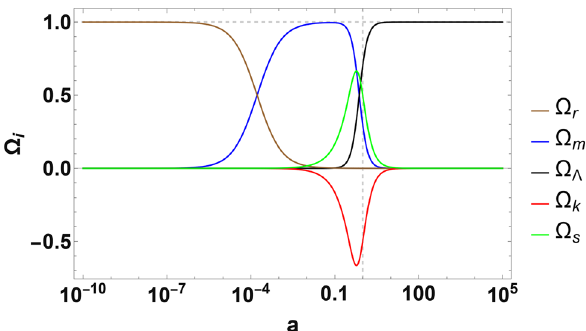
Fig. 1 Qualitative plot of the density parameters as a function of the scalefactorwithlogarithmicscalein a .Thechosenvaluesforthedensity parameters today are (cid:18) r , 0 = 5 × 10 − 5 , (cid:18) m , 0 = 0 . 3, (cid:18) (cid:2), 0 = 0 . 7 and (cid:18) = − 0 . 5.Theinferredvalueforthetorsiondensityparametertoday k , 0 is therefore (cid:18) s , 0 = − ((cid:18) k , 0 + (cid:18) r , 0 ) = 0 . 49995